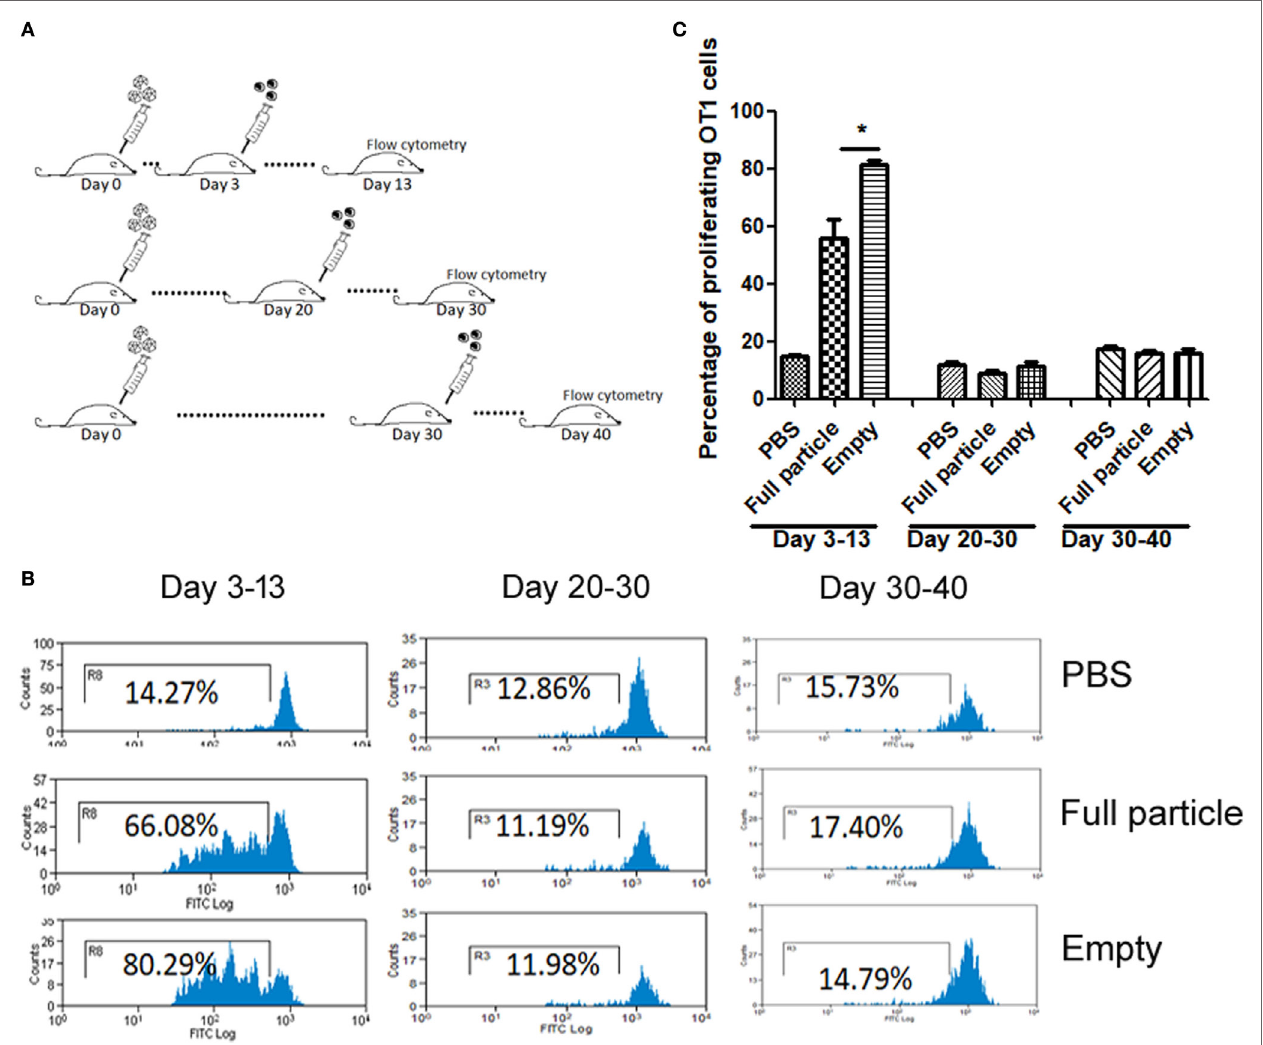
FigUre 2 | The kinetics of capsid antigen presentation from AAV2OVA empty virions in mice. AAVOVA viruses (empty or full) at a dose of 2 × 10 11 were systemically administered via retro-orbital injection into C57BL/6 mice, and at the indicated time points, CFSE-labeled OT-1 T cells were transfused. At day 10 post OT-1 infusion, the proliferation of OT-1 T cells was analyzed by flow cytometry. (a) A scheme for time points of adeno-associated virus administration and OT-1 cells injection as well as assay for OT-1 spleen cell proliferation. (B) Representative flow cytometric histograms. (c) Average T cell proliferation and SD for four